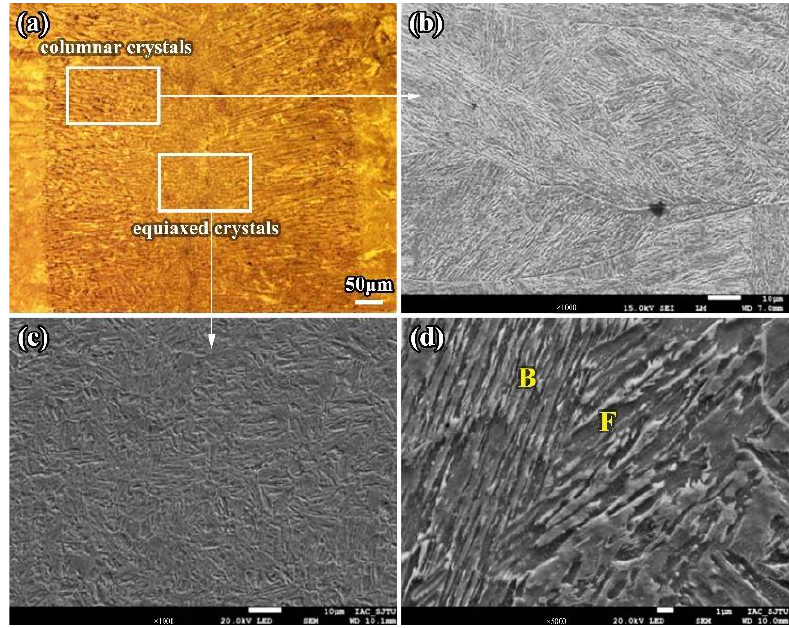
Figure 3. Microstructure of WM of the LBW joint ( a ) Macro-photo in weld center area ( b ) Columnar crystal ( c ) Equiaxed crystal ( d ) Ferrite (F) and bainite (B). ② Coarse-Grained Heat-Affected Zone The CGHAZ is adjacent to the WM, and its higher peak temperature of the thermal cycle ranges from 1100 °C to the liquidus temperature. The austenite phases can stay in this temperature range for a long time and dramatically grow, and then form larger over- heating phases during cooling, which can worsen the mechanical performance of the whole joint. The average grain size of the CGHAZ can reach about 50 μm ; even 100 μm for the grains near to the fusion line. The microstructure features of the CGHAZ are closely related to the heat input. When the heat input increases, acicular ferrite begins to gradually form in the CGHAZ. Acicular ferrite with low hardness and good toughness can significantly improve the impact be- havior of the CGHAZ. If the heat input keeps increasing and the cooling rate decreases, polygonal ferrite phases will increase and acicular ferrite will decrease. Meanwhile, there is a small amount of pearlite that can possibly appear in this area. Due to the lower heat input and faster cooling rate, there are more and more strip- shape bainite, ferrite, and low-carbon martensite phases formed in the CGHAZ. Most of the strip-shape phases initially form from the original austenite grain boundary and grow toward the crystal at a certain angle; each strip maintains a certain phase relationship and a fine structure inside the strip. With lower heat input (9.6 KJ/cm) in the LBW, the internal phases in the CGHAZ are low-carbon martensite and a few bainite and ferrite, as shown in Figure 4.